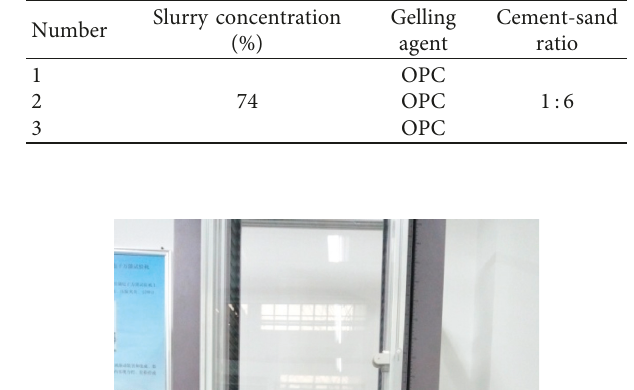
Table 3: Experimental design.